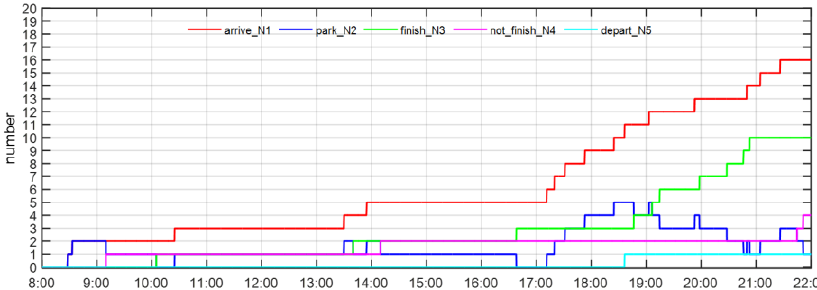
Figure 20. Recording of EV charging under ICDA.